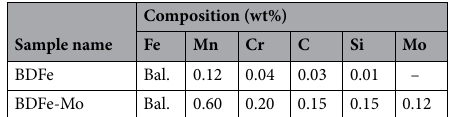
Table 3. Chemical composition of the two BDFe